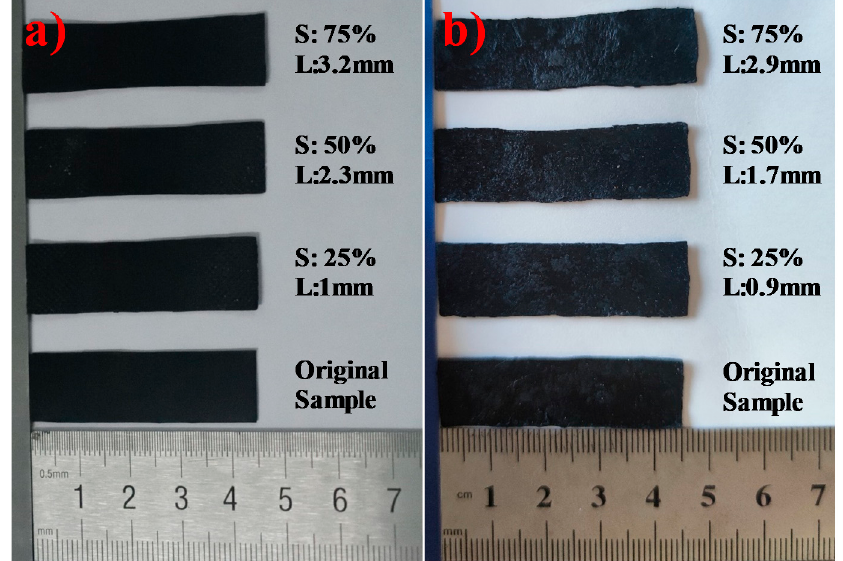
Figure 3. The enhanced length of the GNR-6 ( a ) and MGNR-6 ( b ) composites after treatment by permanent deformation with different strain (S presents the tensile strain elongation and L presents the enhanced length).